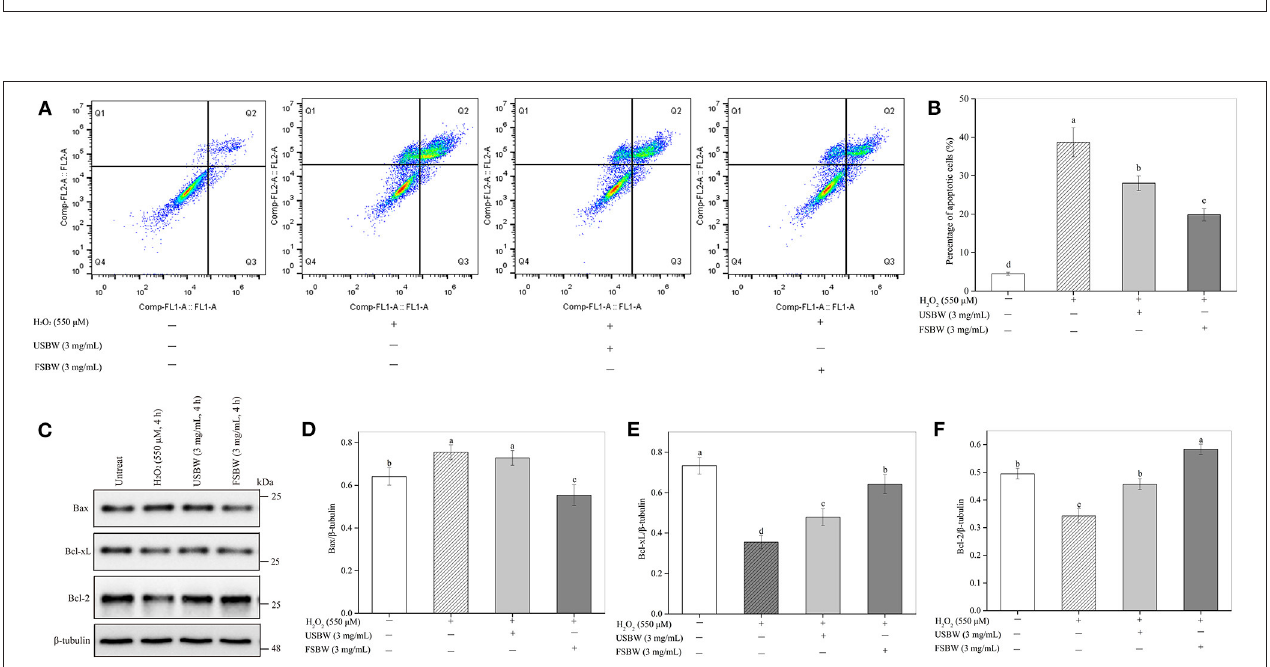
FIGURE 3 | Influence of USBW and FSBW on oxidative stress. (A) ROS production; (B) Statistical histogram in (A) ; (C) Catalase (CAT) activity; (D) Superoxide dismutase (SOD) activity. (E) Glutathione peroxidase (GSH-Px) activity. p < 0.05 was considered as the significant level. The small letters were used to indicate the significant difference and the ordering of results.